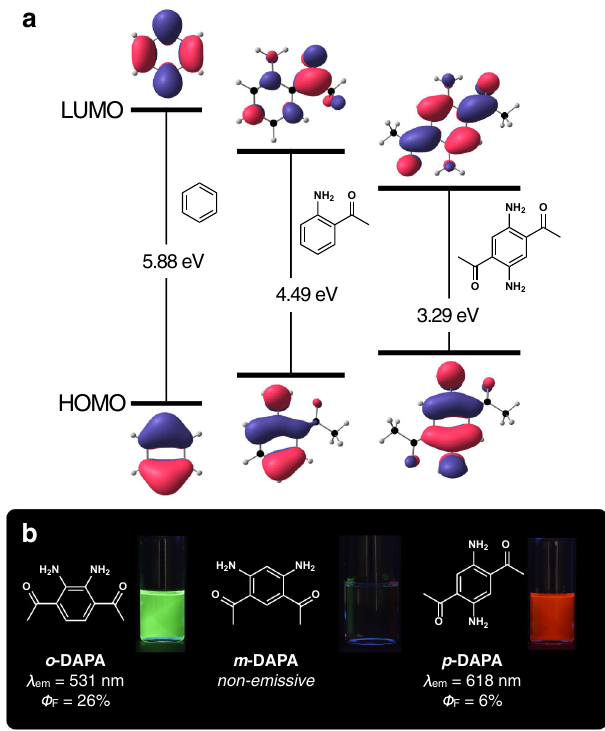
Fig. 1 Single benzene fl uorophores. a HOMO – LUMO energy level diagrams of benzene derivatives calculated at the MRSF/BH&HLYP/6- 31 G* level of theory. b Chemical structures of DAPA isomers along with photographic images of CHCl 3 solution samples taken under 365 nm UV lamp. LUMO lowest unoccupied molecular orbital, HOMO highest occupied molecular